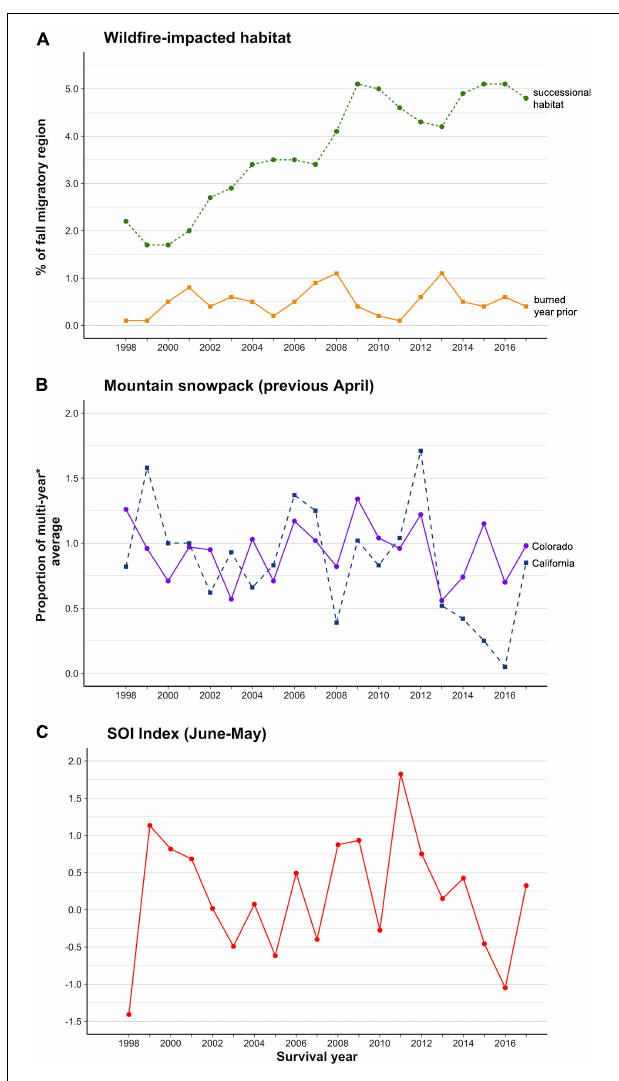
FIGURE 3 | Variation in migratory environmental variables over the mark-recapture period (1998–2017). (A) The percentage of the fall migratory region burned 2-10 years before the survival year (‘successional habitat’) and one year before to the survival year (‘burned year prior’), (B) Relative April snowpack depth in the Colorado Rockies and California Sierra Nevada in the year before the survival year and, (C) SOI climate index.